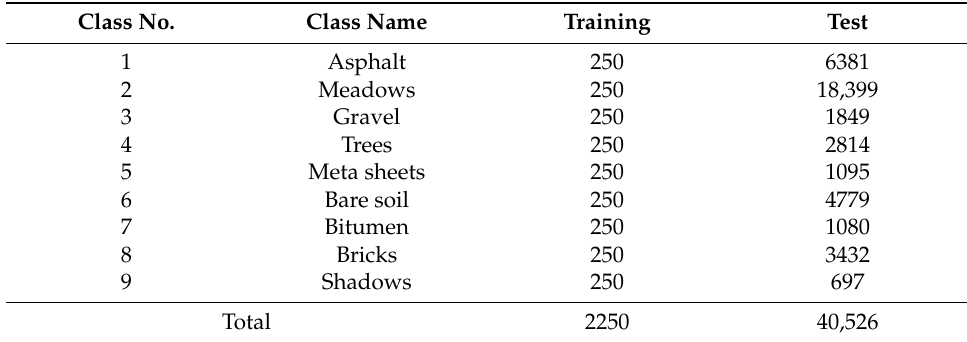
Table 3. Class information for the University of Pavia image.